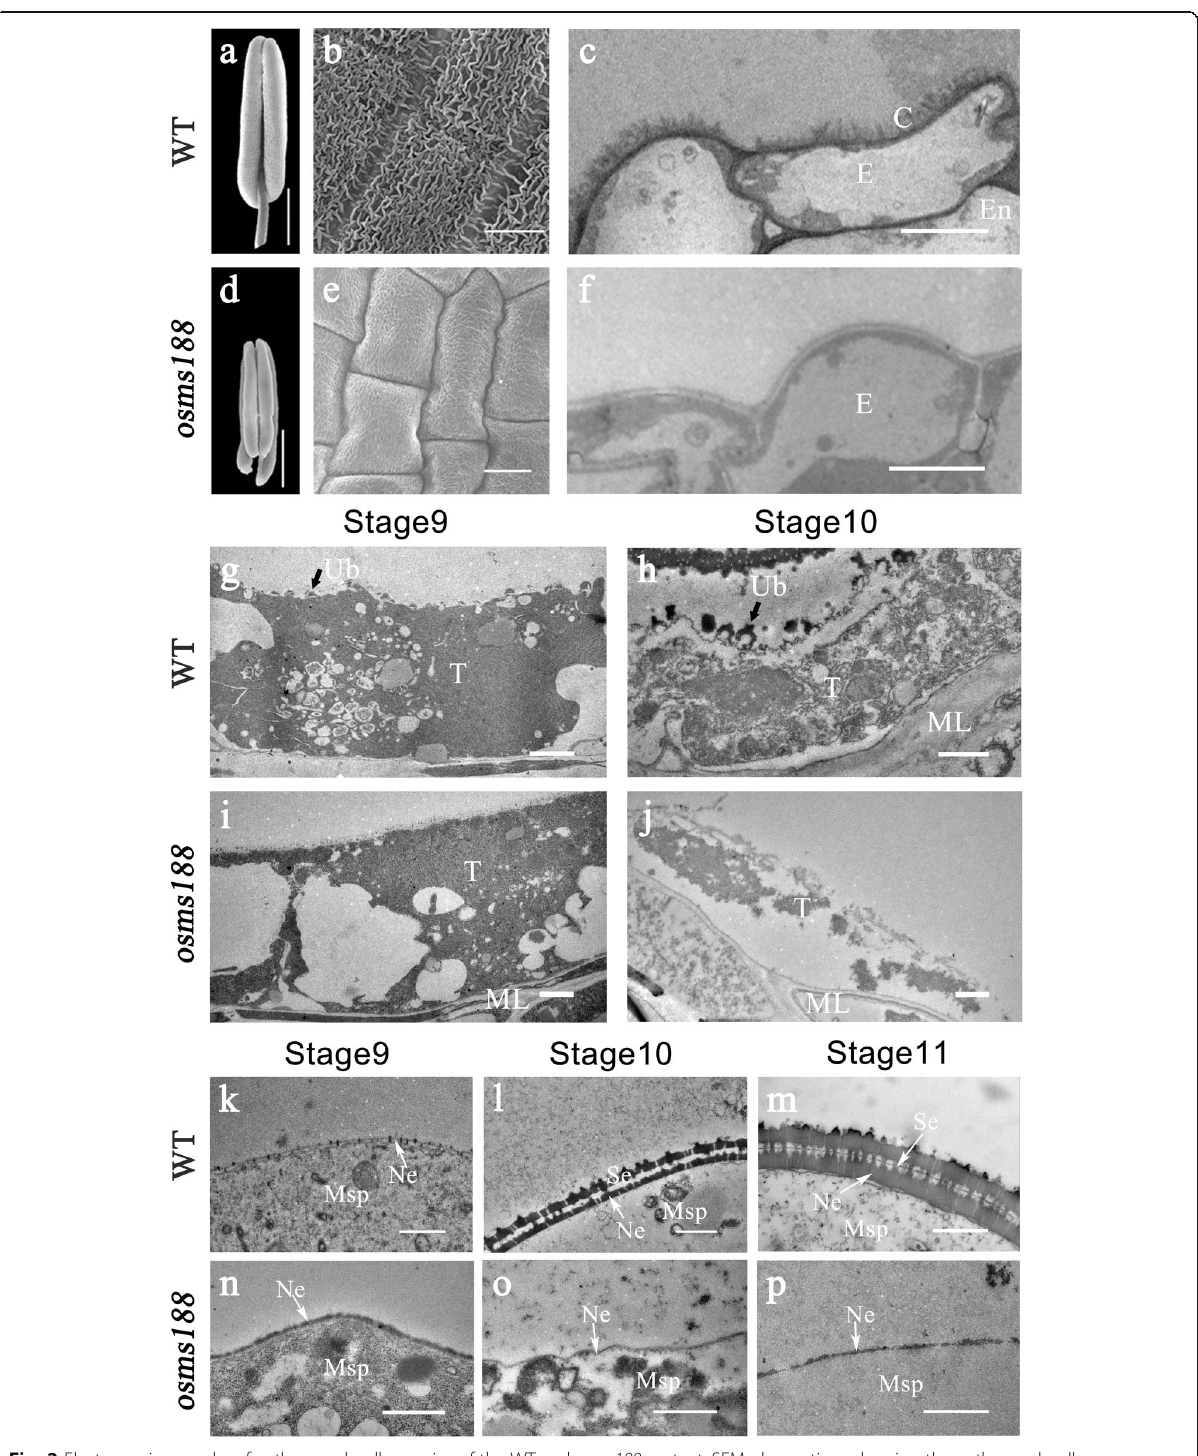
Fig. 2 Electron micrographs of anthers and pollen grains of the WT and osms188 mutant. SEM observations showing the anther and pollen development of the WT ( a - b ) and osms188 ( d - e ). Anther morphology of the WT ( a ) and osms188 ( d ) and the epidermal surfaces of WT ( b ) and osms188 ( e ) anthers. TEM observations of tapetum development and sexine formation of the WT ( c , g , h , k , l , m ) and osms188 ( f , i , j , n , o , p ). Cuticle layer of the WT ( c ) and osms188 ( f ). The tapetal cells of the WT ( g ) and osms188 ( i ) at stage 9 and the tapetal cells of the WT ( h ) and osms188 ( j ) at stage 10. Pollen wall formation in the WT ( k , l , m ) and osms188 ( n , o , p ) during stages 9 – 11. C, cuticle; E, epidermis; En, endothecium; ML, middle layer; Msp, microspore; Ne, nexine; Se, sexine; T, tapetum; Ub, Ubisch body. Bars: ( a , d ) 500 μ m; ( b , e ) 20 μ m; ( c , f ) 5 μ m; ( g - l , o - p ) 1 μ m; ( m , n ) 0.5 μ